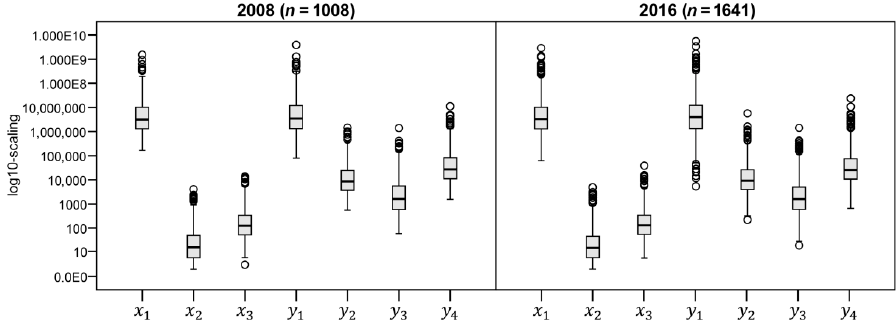
Figure 3. Boxplot of input and output variables, 2008 and 2016.